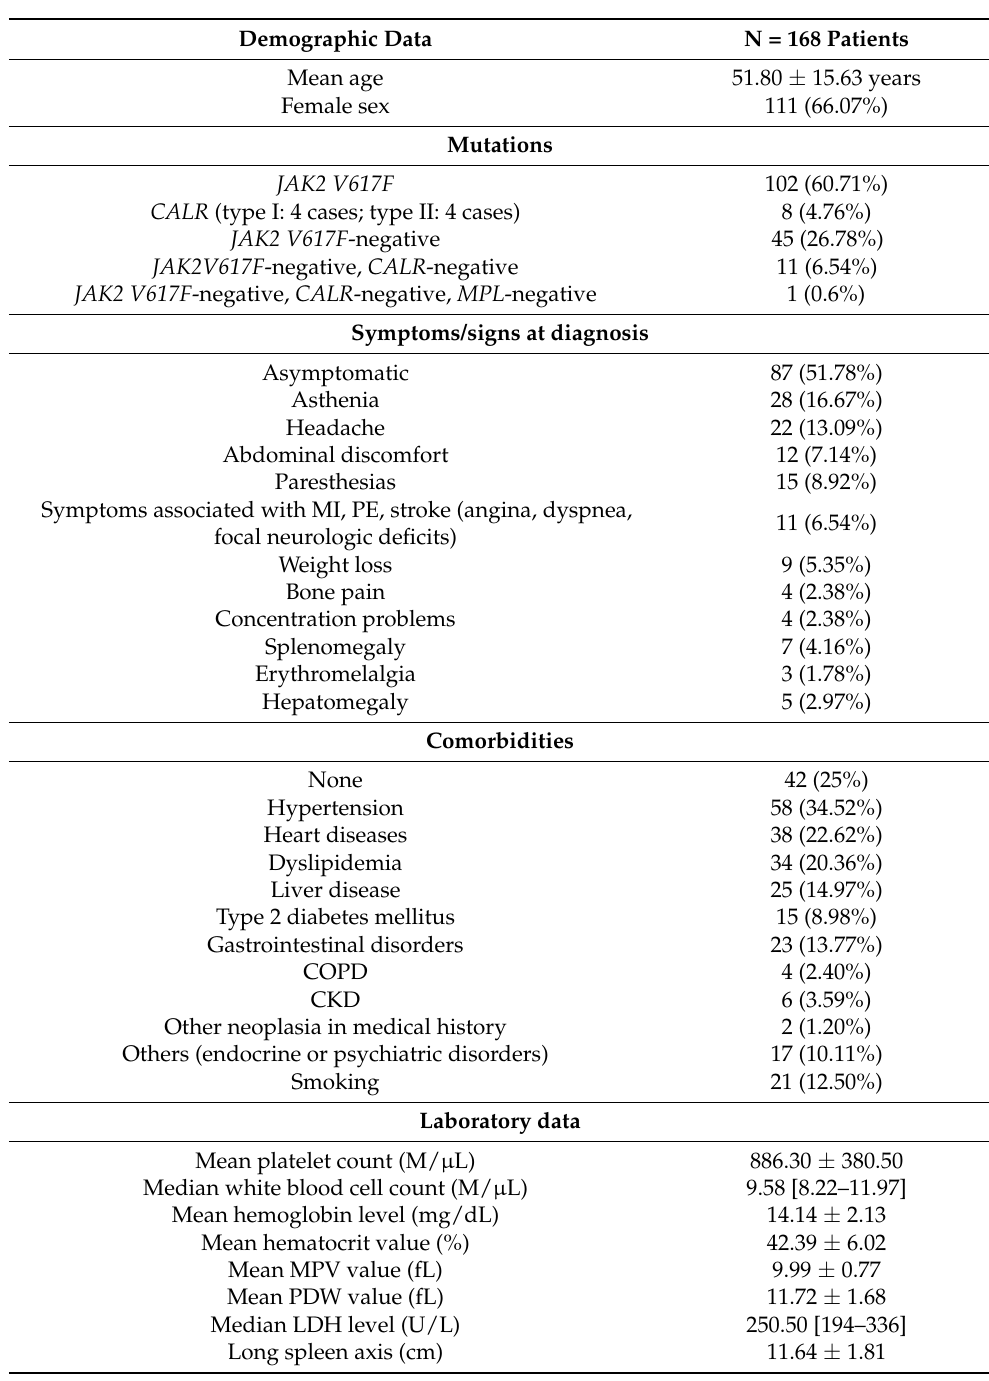
Table 1. General characteristics of ET patients. Demographic